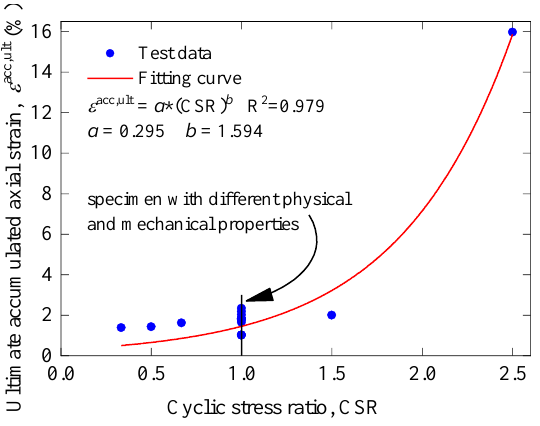
Figure 7. The ultimate accumulated axial strain versus the cyclic stress ratio.